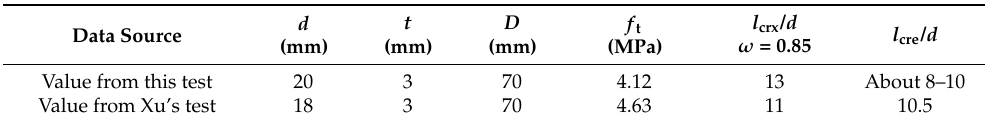
Table 6. Comparison between the test and calculated values of the critical lapping length of specimens with grouting